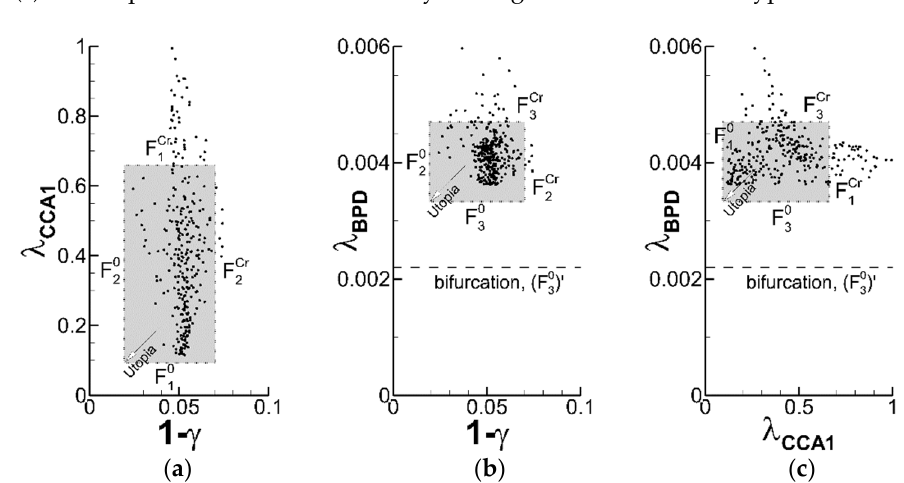
Figure 12. DoE 1 results—Projected 3D criterion space into three individual 2D components ( a – c ).